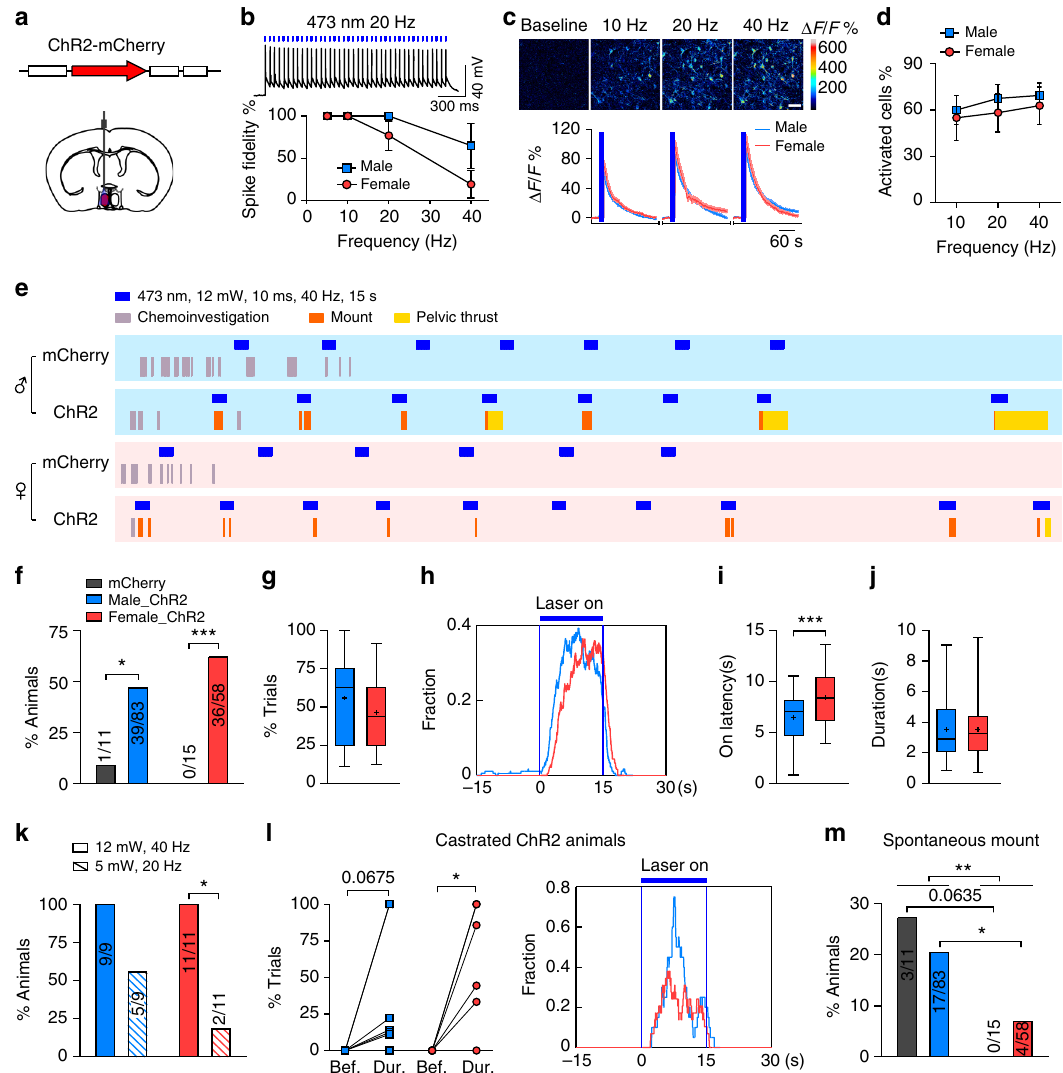
Fig. 2 Optogenetic activation of male-typical mounting in both sexes. a The strategy to optogenetically activate the mPOA. b Electrophysiological recordings of ChR2-expressing neurons in freshly cut brain slices. N = 25 male cells and 23 female cells. c Calcium imaging of acute brain slices were performed under a two-photon microscope at different stimulation frequencies as representative images showing at the top. Δ F / F values were averaged cross cells and plotted at the bottom with the blue bars indicating laser stimulation and the line and the shading indicating the mean and the s.e.m., respectively. N = 358 male neurons and 292 female neurons. Scale bar, 50 μ m. d Average percentage of neurons activated at each tested frequency. N = 6 brain sections for males and 4 for females. e Representative raster plots of behaviors (color coded) displayed by mCherry and ChR2 animals of either sex during a behavioral trial in which a hormonal primed ovariectomized female was given as the stimulus. Blue bars indicate periods of light stimulation. f – j Photostimulation elicited male-typical mounting behavior toward hormonal primed ovariectomized females. The percentage of animals that displayed mounting behavior during photostimulation ( f ), trial-by-trial occurrence ( g ), average distribution ( h ), the latency ( i ), and average duration ( j ) of optogenetically activated mounting behavior were plotted. N = 83 ChR2 and 11 mCherry for males, and 58 ChR2 and 15 mCherry for females. k Percentage of ChR2 animals that displayed light-induced mounting behavior at low power of stimulation and high power. N = 9 males and 11 females. l Occurrence and distribution of mounting behavior before (bef.), during (dur.), and after light stimulation in those ChR2 animals, which had been castrated for > 3 weeks. N = 9 males and 6 females. m Spontaneous mounting behavior that occurred outside of photostimulation. N = 83 ChR2 and 11 mCherry for males, and 58 ChR2 and 15 mCherry for females. Fisher ’ s exact test in f , k , and m . Unpaired t test in i . Paired t test in l . * p < 0.05, ** p < 0.01, *** p <